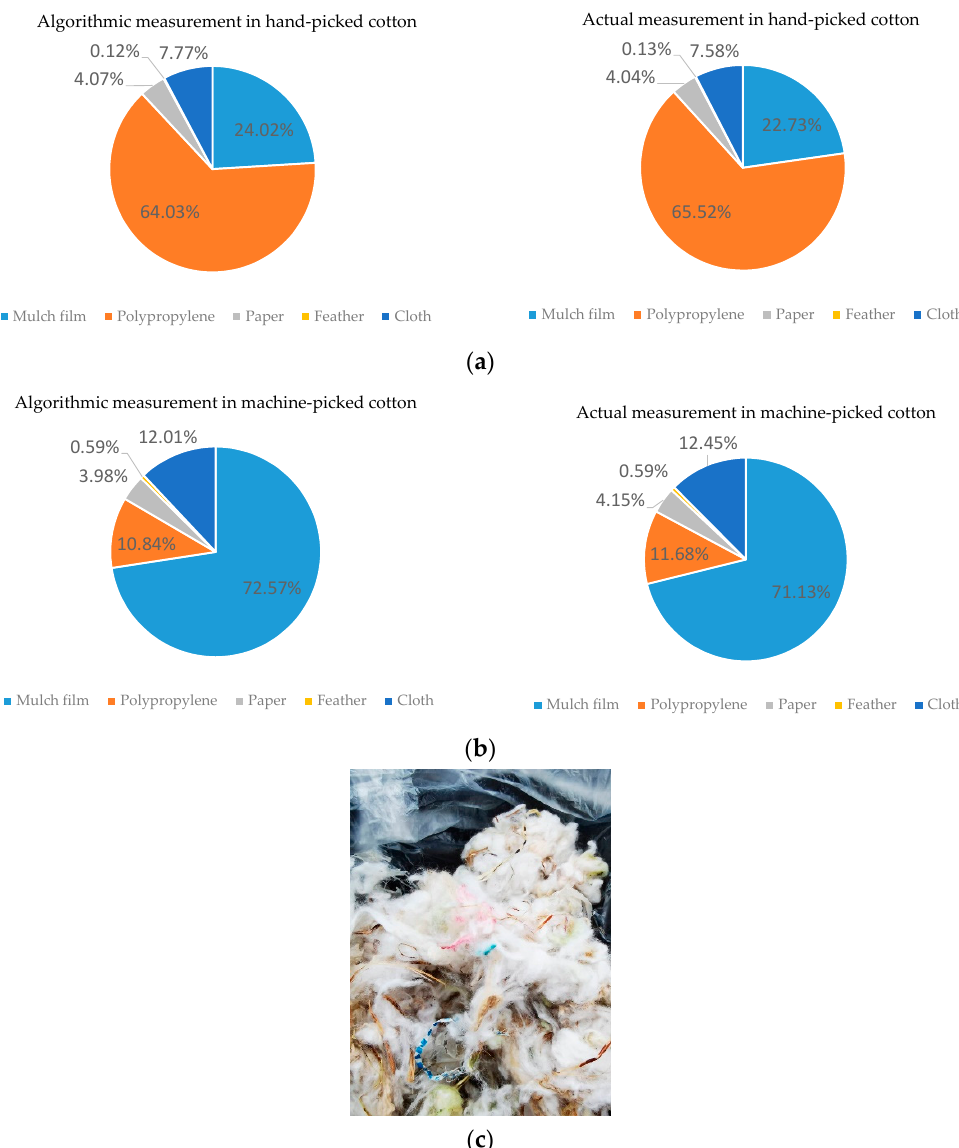
Figure 17. Size estimation of the algorithm compared with actual size in a given time. ( a ) Hand-picked cotton; ( b ) machine-picked cotton; and ( c ) foreign fiber in the waste bag. Table 8. The estimated size results of foreign fibers in a given time.